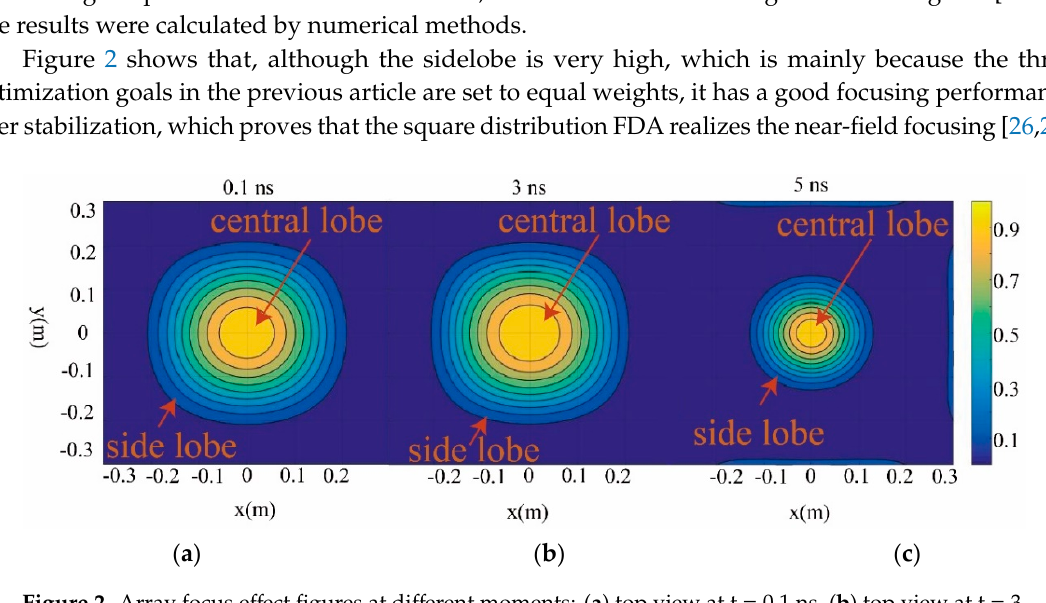
Figure 2. Array focus effect figures at different moments: ( a ) top view at t = 0.1 ns, ( b ) top view at t = 3 ns and ( c ) top view at t = 5 ns.